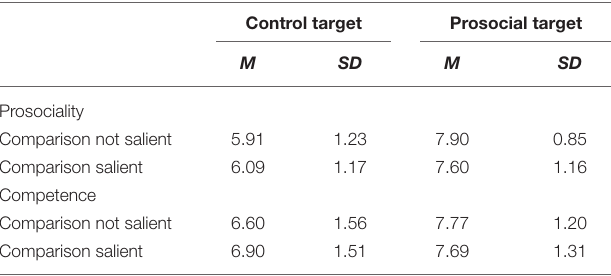
TABLE 2 | Mean target prosociality and competence ratings per condition in Experiment 1.